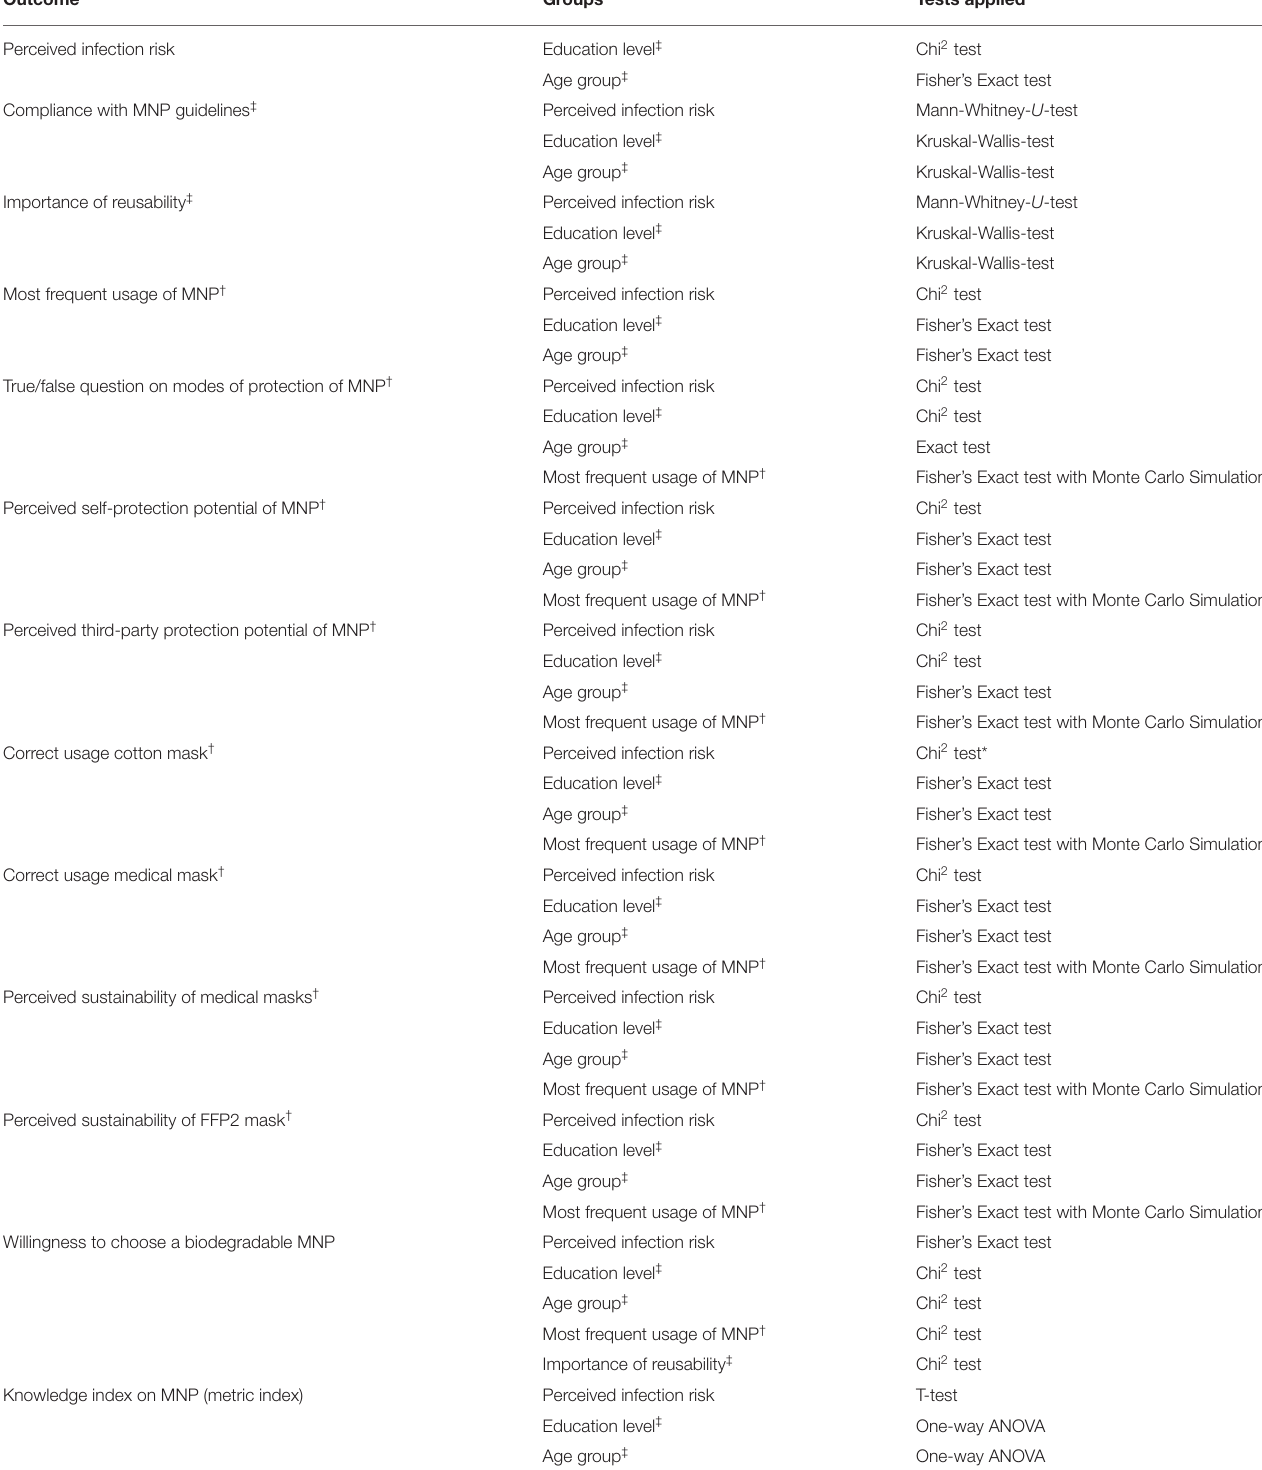
TABLE 2 | Overview of variable characteristics and statistical tests (binomial, † categorial, ‡ ordinal).